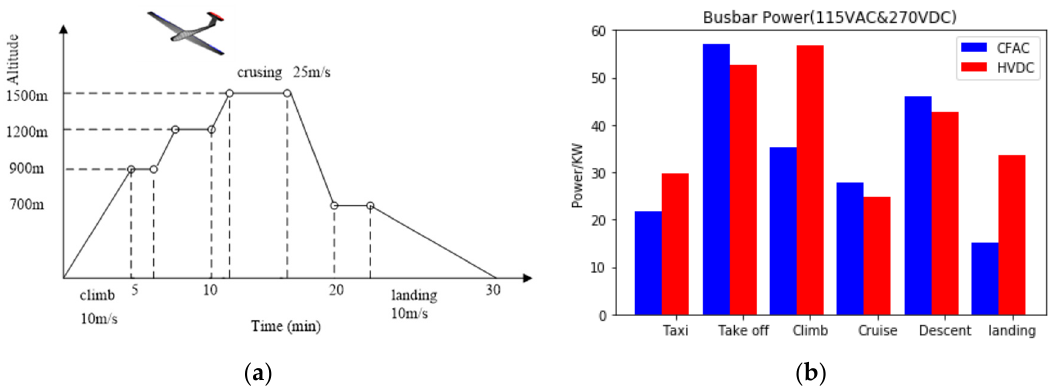
Figure 4. The typical flight profile ( a ) and power demand ( b ) for the small size aircraft.